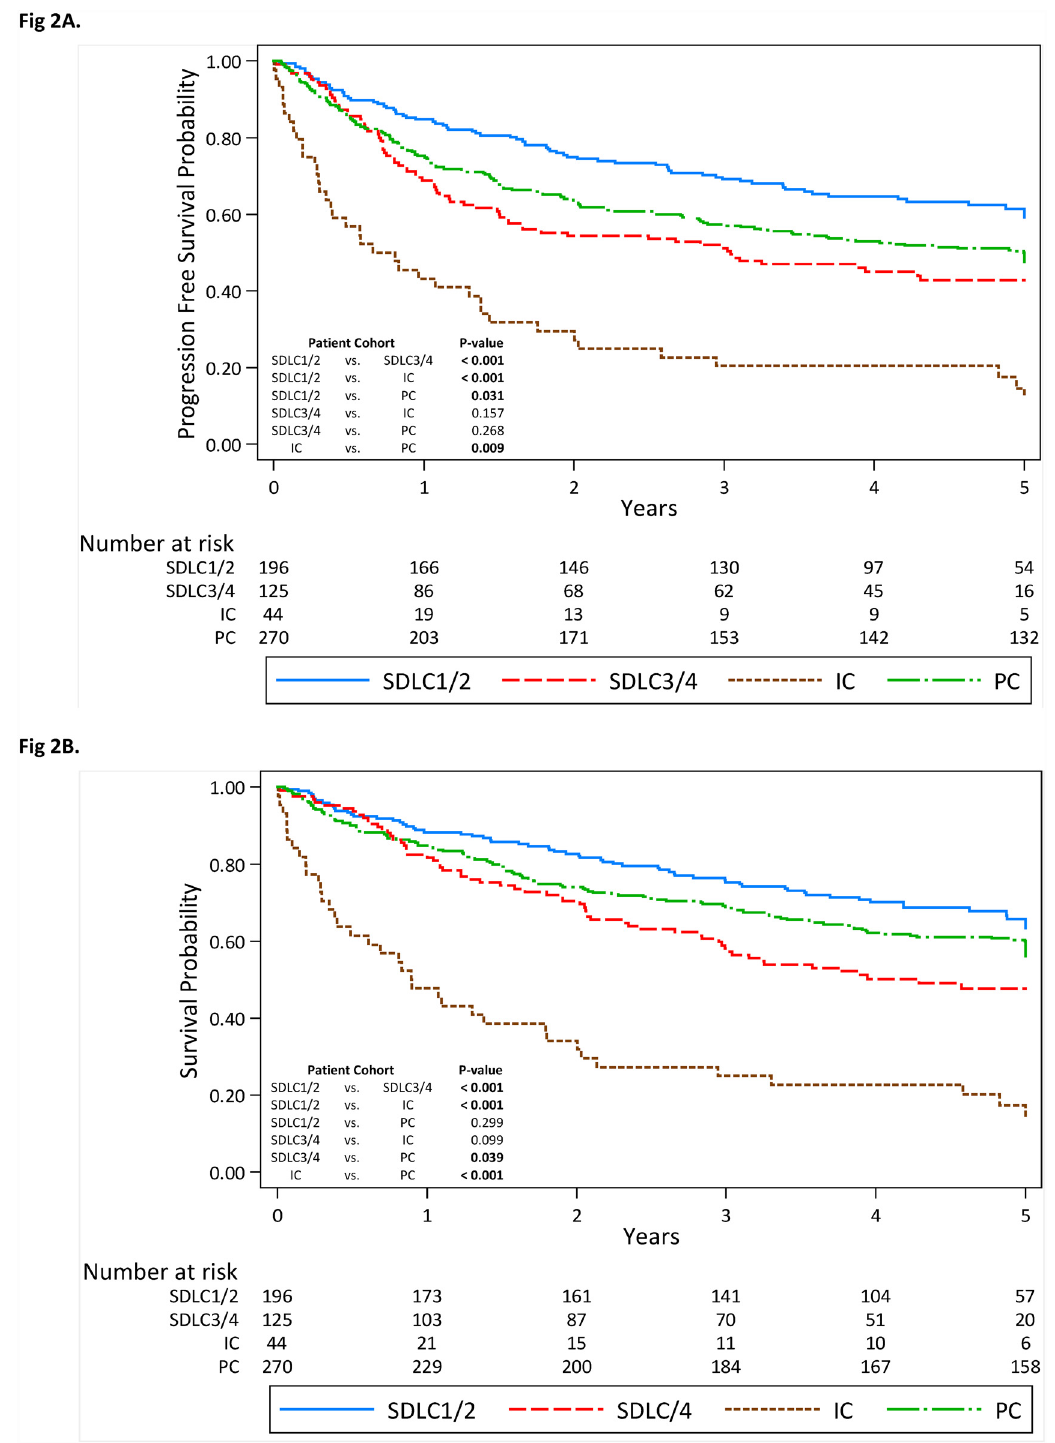
Fig 2. Kaplan-Meier estimates and number of subjects at risk for (A) progression free survival and (B) overall survival in the prevalence-, interval-, and grouped screen-detected lung cancers. Abbreviations: SDLC1/ 2 = Combined screen-detected lung cancers following positive screens at T1 and T2 rounds in cohorts with T0 positive screens; SDLC3/4 = Combined screen-detected lung cancers following positive screens at T1 and T2 rounds among cohorts with T0 or T0 and T1 negative screens; PC = Prevalence lung cancer cohort; IC = Interval cancer